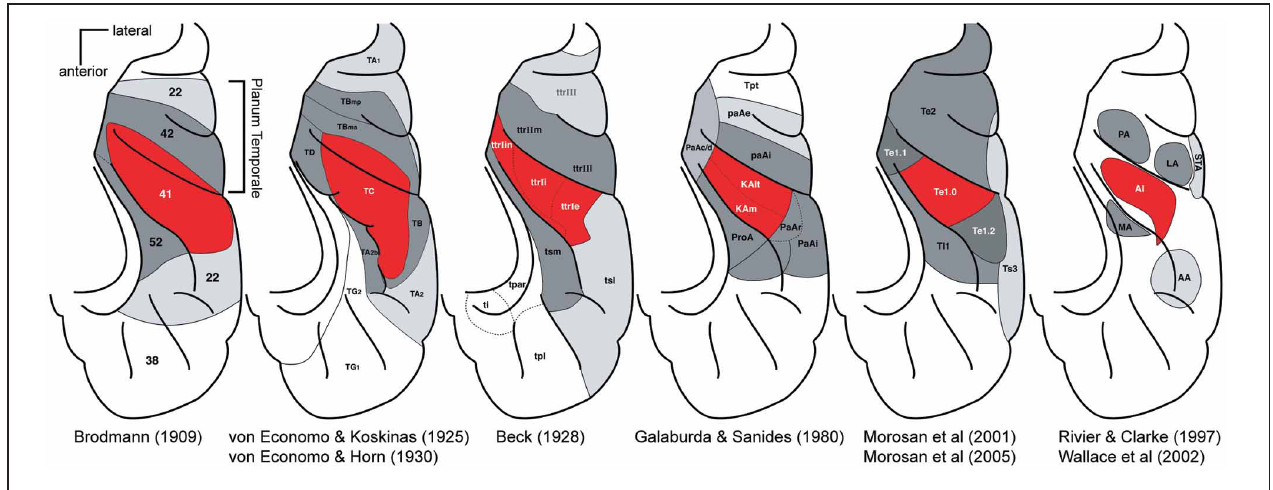
FIGURE 2 | Parcelations of the human superior temporal cortex by different investigators. For each panel, the locations of major auditory cortical regions are drawn on a standardized schematic of the superior